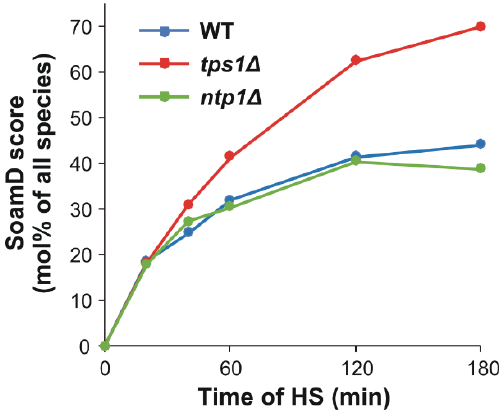
Figure 3. SoamD scores of overall lipidome changes upon heat stress (HS). Yeast cells were heat- stressed at 40 °C for 0–180 min and the sum of absolute mol% differences (SoamD) relative to the untreated control were calculated for each time point based on mean values from n = 3 independent experiments as detailed in point 4.6. WT, wild-type; tps1 Δ , trehalose-deficient; ntp1 Δ , trehalase-de- ficient S. pombe strains.